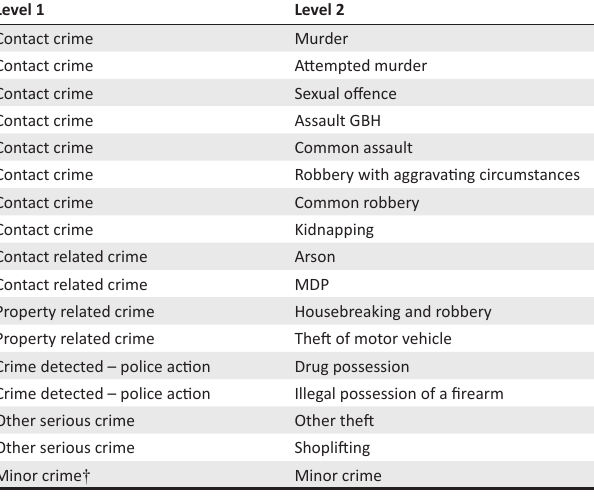
TABLE 3: The following crime classification was used for